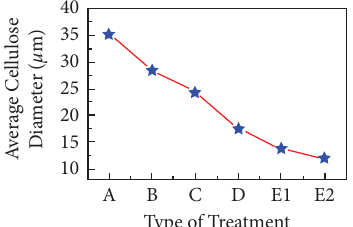
Figure 6: Average diameter of cellulose extracted from sugarcane